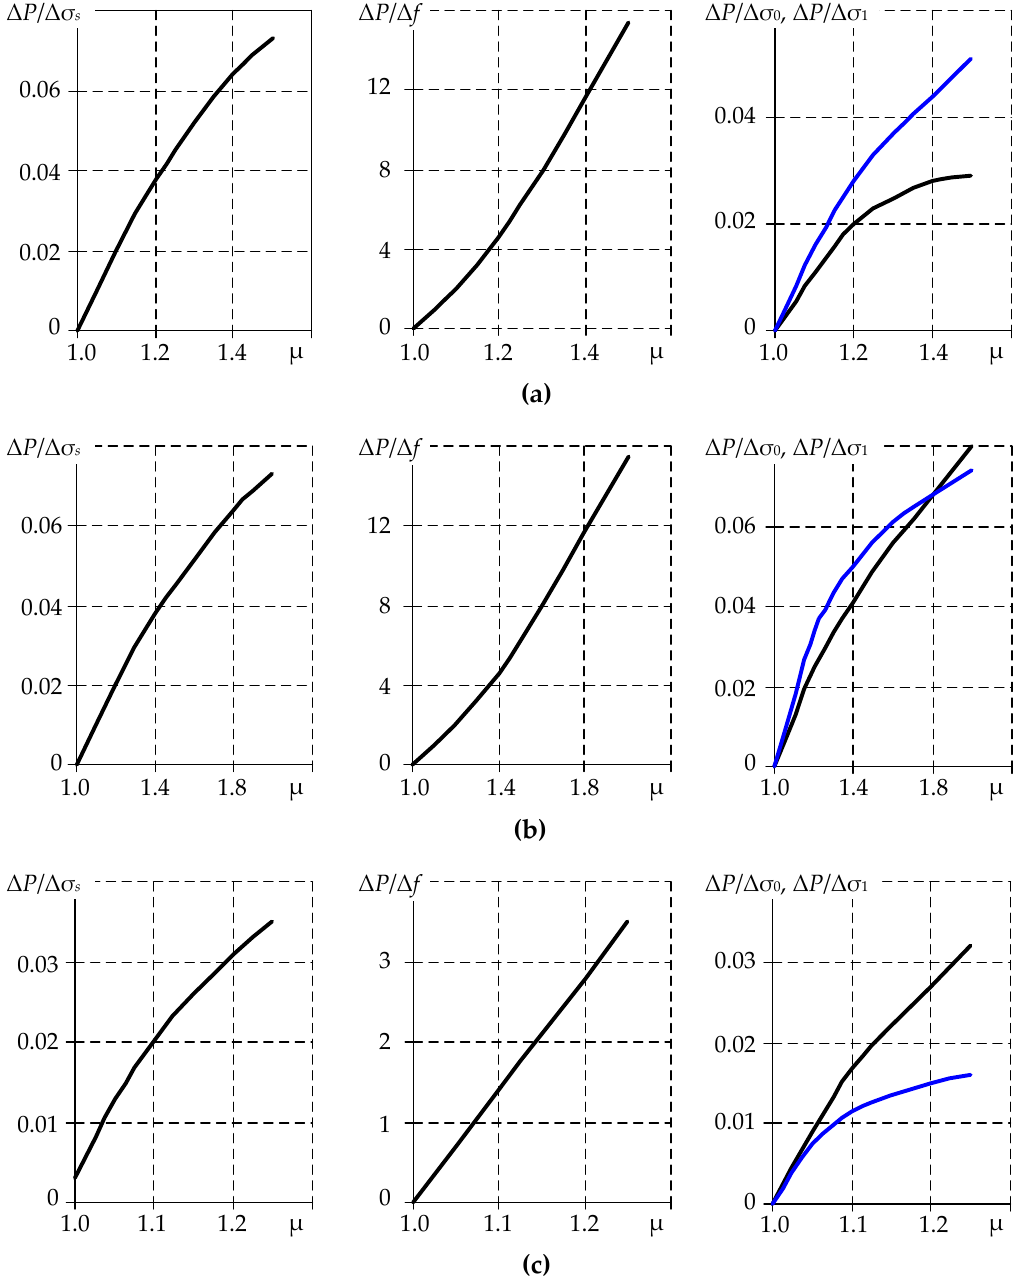
Figure 6. Dependencies of Partial Derivatives on Drawing When Rolling Steel 70 for the Pass Systems “Circle-Square” ( a ); “Square-Square” ( b ); “Square-Circle” ( c ).